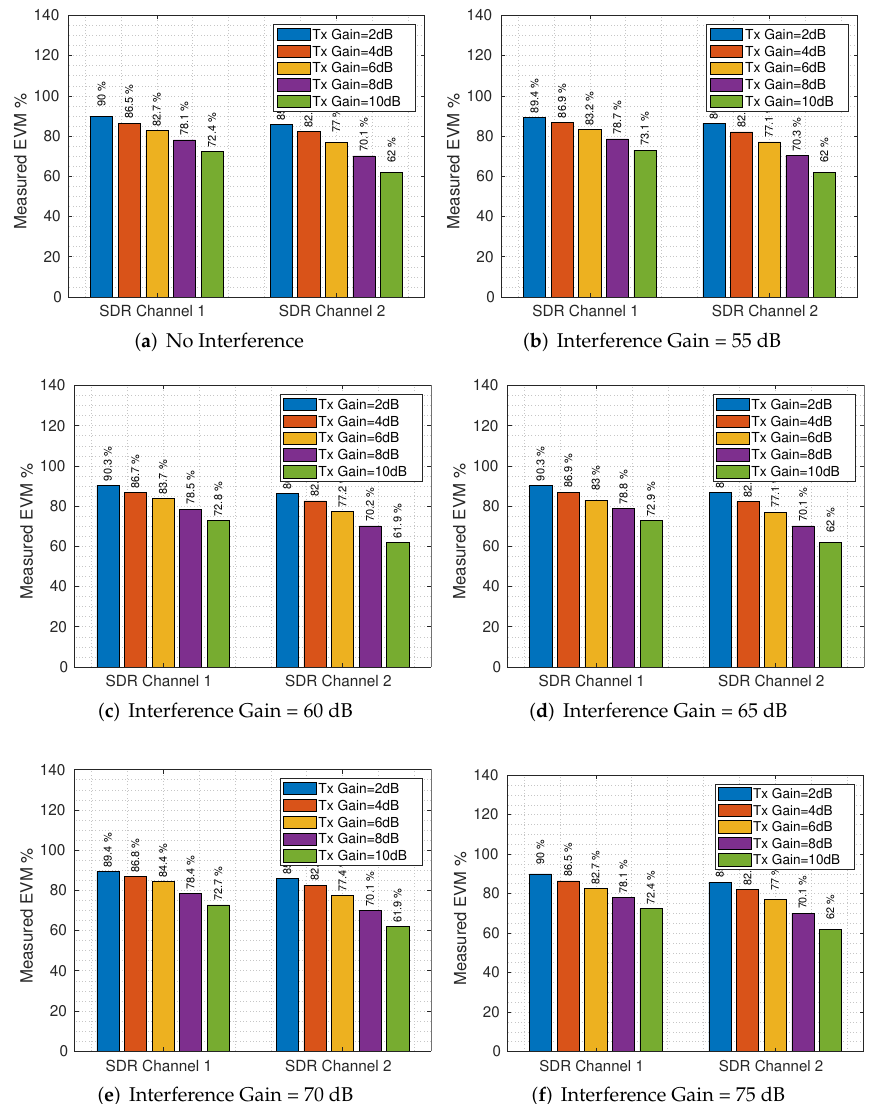
Figure 11. Measured MIMO EVM of SDR channel 1 and SDR channel 2 in the presence of the MIMO interference when the metal enclosure was loaded with ten pieces of RF absorber cones. The Tx gain was swept from 2 to 10 dB. The AGC gain was set to 50